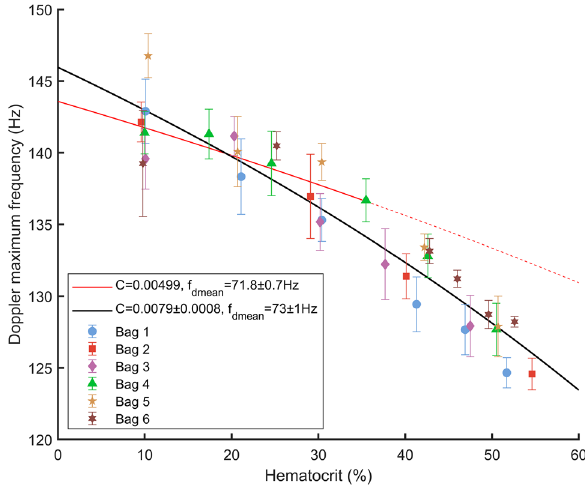
Figure 5. Measured Doppler maximum frequencies with a fit of Eq. (7) (black line) and with a fit of Eq. (7) restricted to hematocrits under 35% (red line). The fit on the whole hematocrit range has been performed with C and f dmean as fitting parameters and the restricted fit has been performed with f dmean as the only fitting parameter and with C fixed to the Walburn and Schneck value (1976).